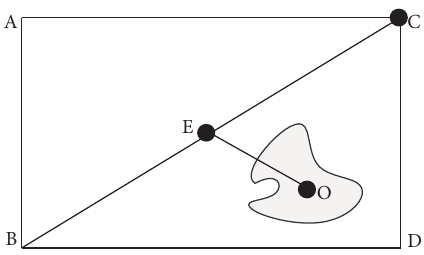
Figure 5: Illustration of the centerness calculation. We define centerness as the ratio between EO and EC.